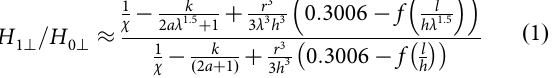
Fig. 2d – f, respectively, and the folding patterns of modes IV and V were programmed using magnetization direction depicted in Fig. 2g. Their electric outputs were systematically investigated